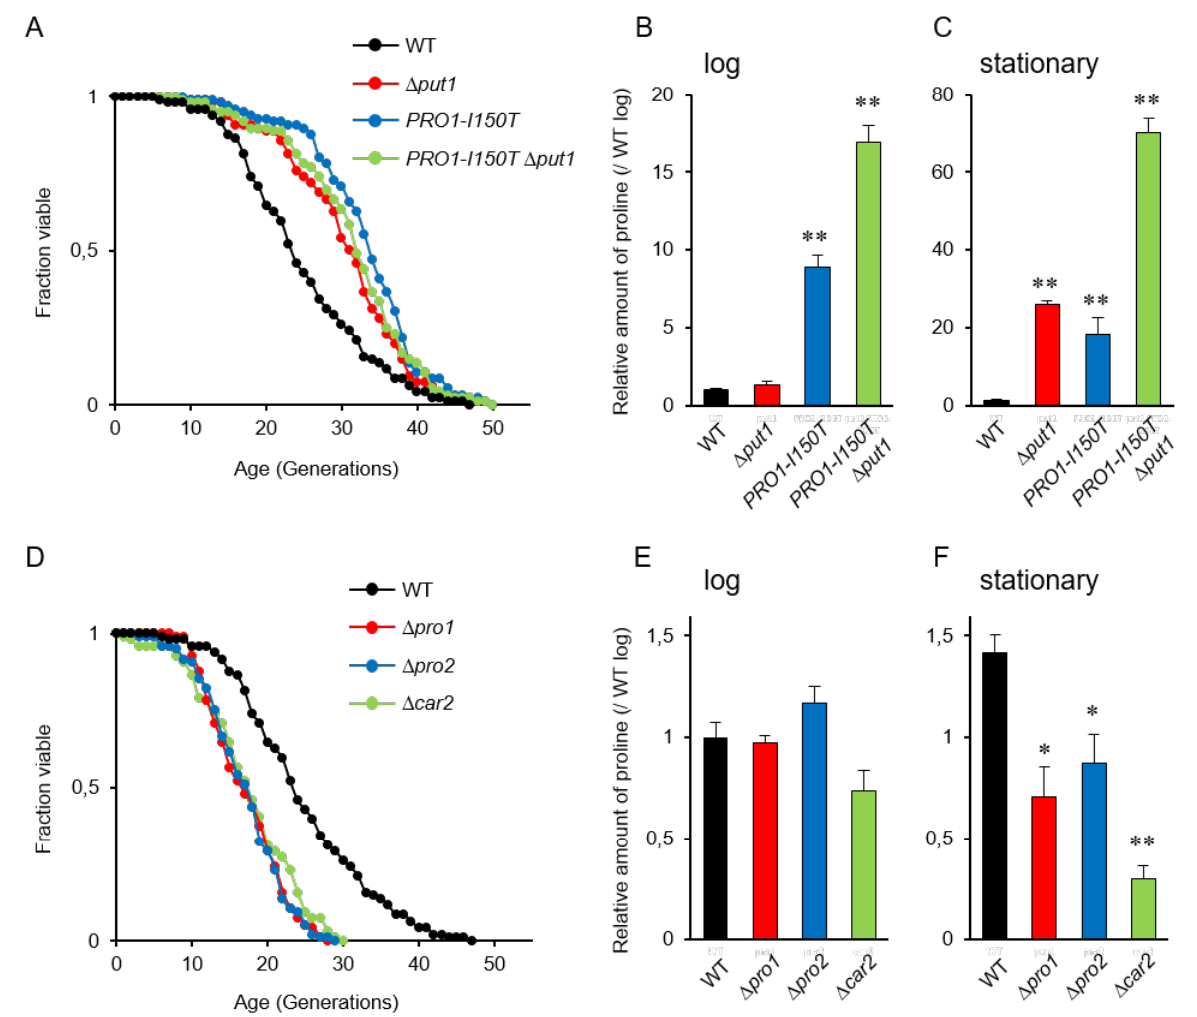
FIGURE 1: Intracellular proline regulates the yeast replicative lifespan. (A and D) Lifespan of yeast cells with increased or decreased pro- line levels. The data for the wild-type strain (WT; BY4741) was the same as Figure 1A and 1D. The results of other mutants, which were analyzed independently, and WT were combined. (B, C, E and F) Intracellular proline levels in the indicated strains at log and stationary phases compared with that in WT at log phase. The values are the means and standard deviation of results from three independent exper- iments. *, p < 0.05; **, p < 0.01, versus WT calculated with the Dunnett’s